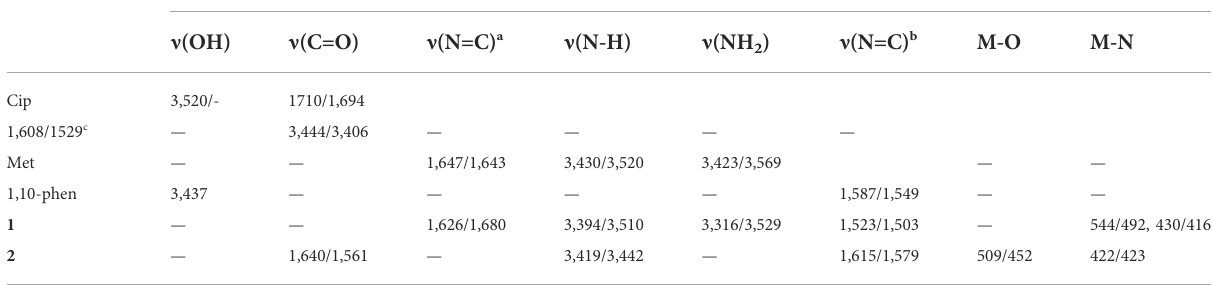
TABLE 1 Vibrational frequencies (experimental/calculated) of selected functional groups of the ligands and their metal complexes.